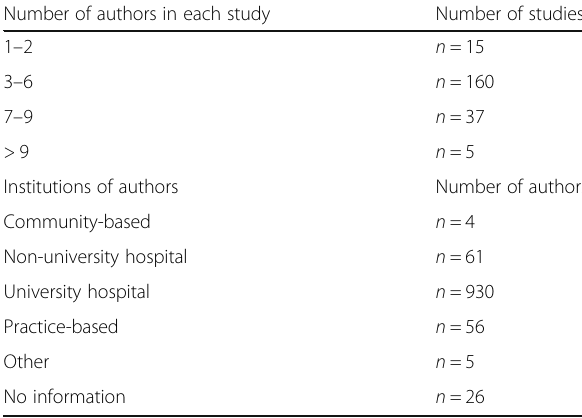
Table 2 Authorship characteristics of included studies ( n =